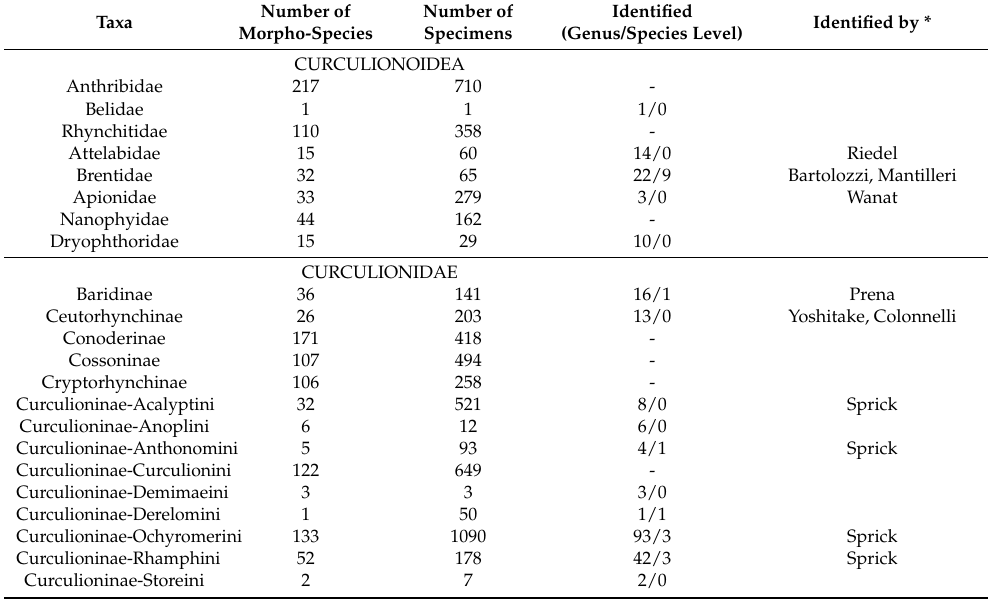
Table 1. Canopy weevils from the superfamily Curculionoidea in the samples from Malaysia (Borneo). Number of Taxa